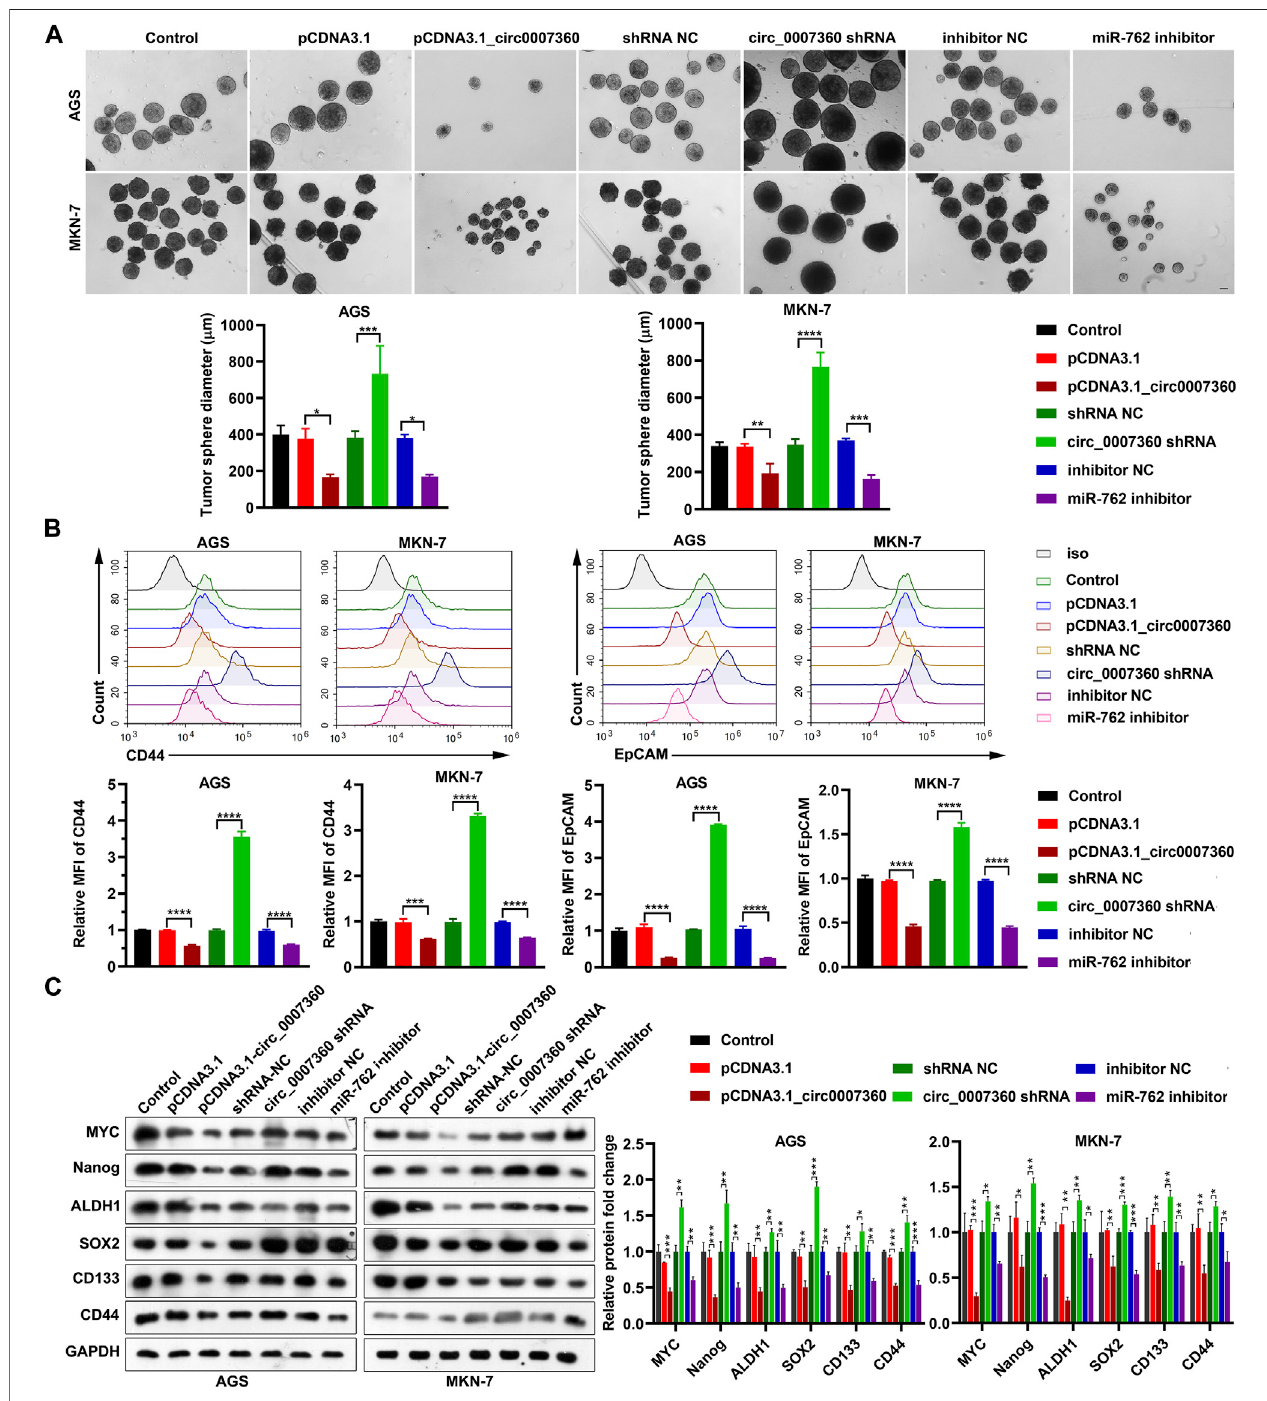
FIGURE 5 | Circ0007360 inhibits while miR-762 promotes the stemness of gastric cells. (A) Representative images and quanti fi cation of tumor sphere formation resultsofstemnessmeasuredincellswithectopicexpression of circ0007360 ,knockdown of circ0007360, or miR-762 . (B) Representativeimagesandquanti fi cationof fl owcytometryanalysisresultsoftheexpressionofCD44andEpCAMonthecellsurfaceincellswithectopicexpressionof circ0007360 ,knockdownof circ0007360, or miR-762 . (C) Representative images and quanti fi cation of the western blotting detection of stemness markers expressed in cells with ectopic expression of circ0007360 , knockdown of circ0007360, or miR-762 .